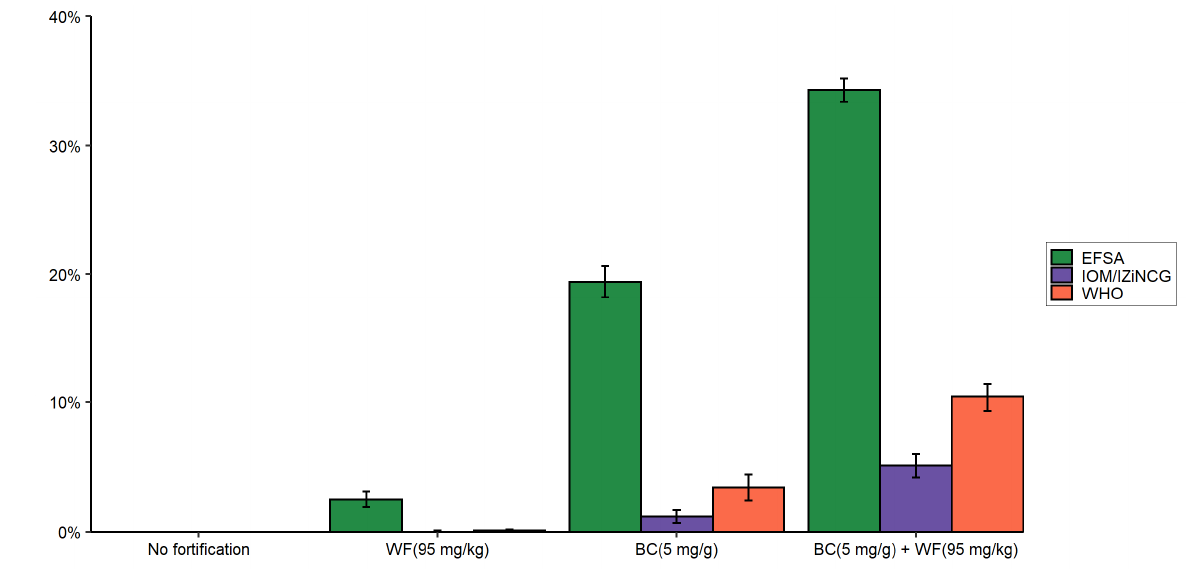
Figure 8. Prevalence ( ± SE) of zinc intake above the UL considering the contribution of zinc fortification programs among women in Cameroon: estimated based on WHO, IZINCG, IOM, and EFSA UL reference values. EFSA, European Food Safety Authority; IOM, US Institute of Medicine; IZiNCG, International Zinc Nutrition Consultative Group; WHO, World Health Organization; WF, wheat flour; BC, bouillon cubes; UL, tolerable upper intake level